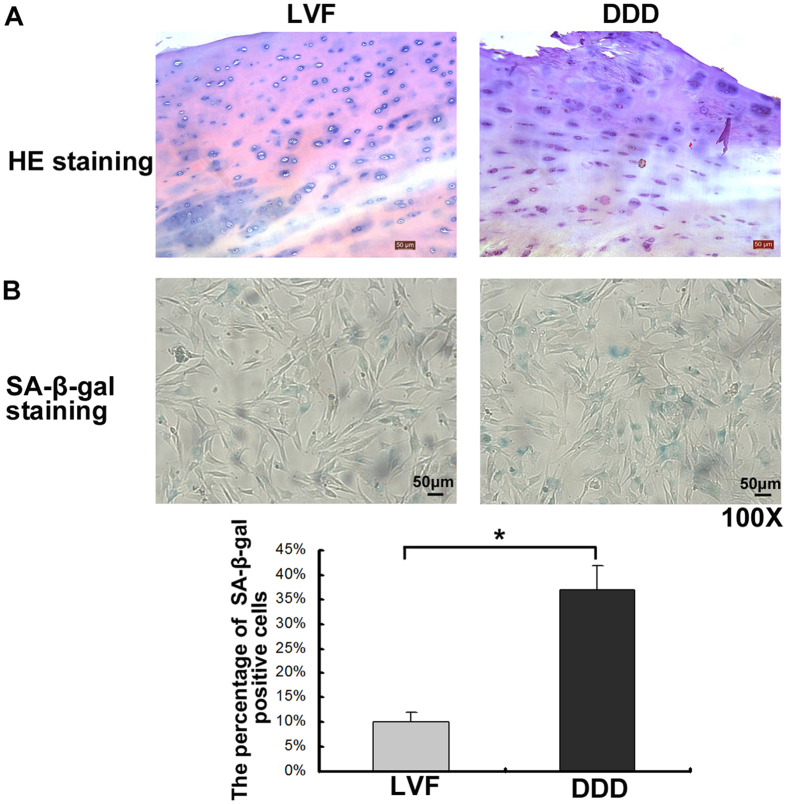
HE and SA-β-galactosidase staining of CEP samples (100X).(A) HE stainings of CEP samples obtained from patients with IVF and DDD. (B) SA-β-galactosidase stainings of CEP cells obtained from patients with LVF and DDD (100X). (C) The number of SA-β-Gal-positive cells (blue) and staining intensity of the CEP cells obtained from all the DDD patients were significantly greater than those of the CEP cells obtained from all the LVF patients. Three independent experiments were performed on the tissues from three patients for each group, and the data was denoted in terms of mean ± SD. *P < 0.05. NS: P > 0.05.